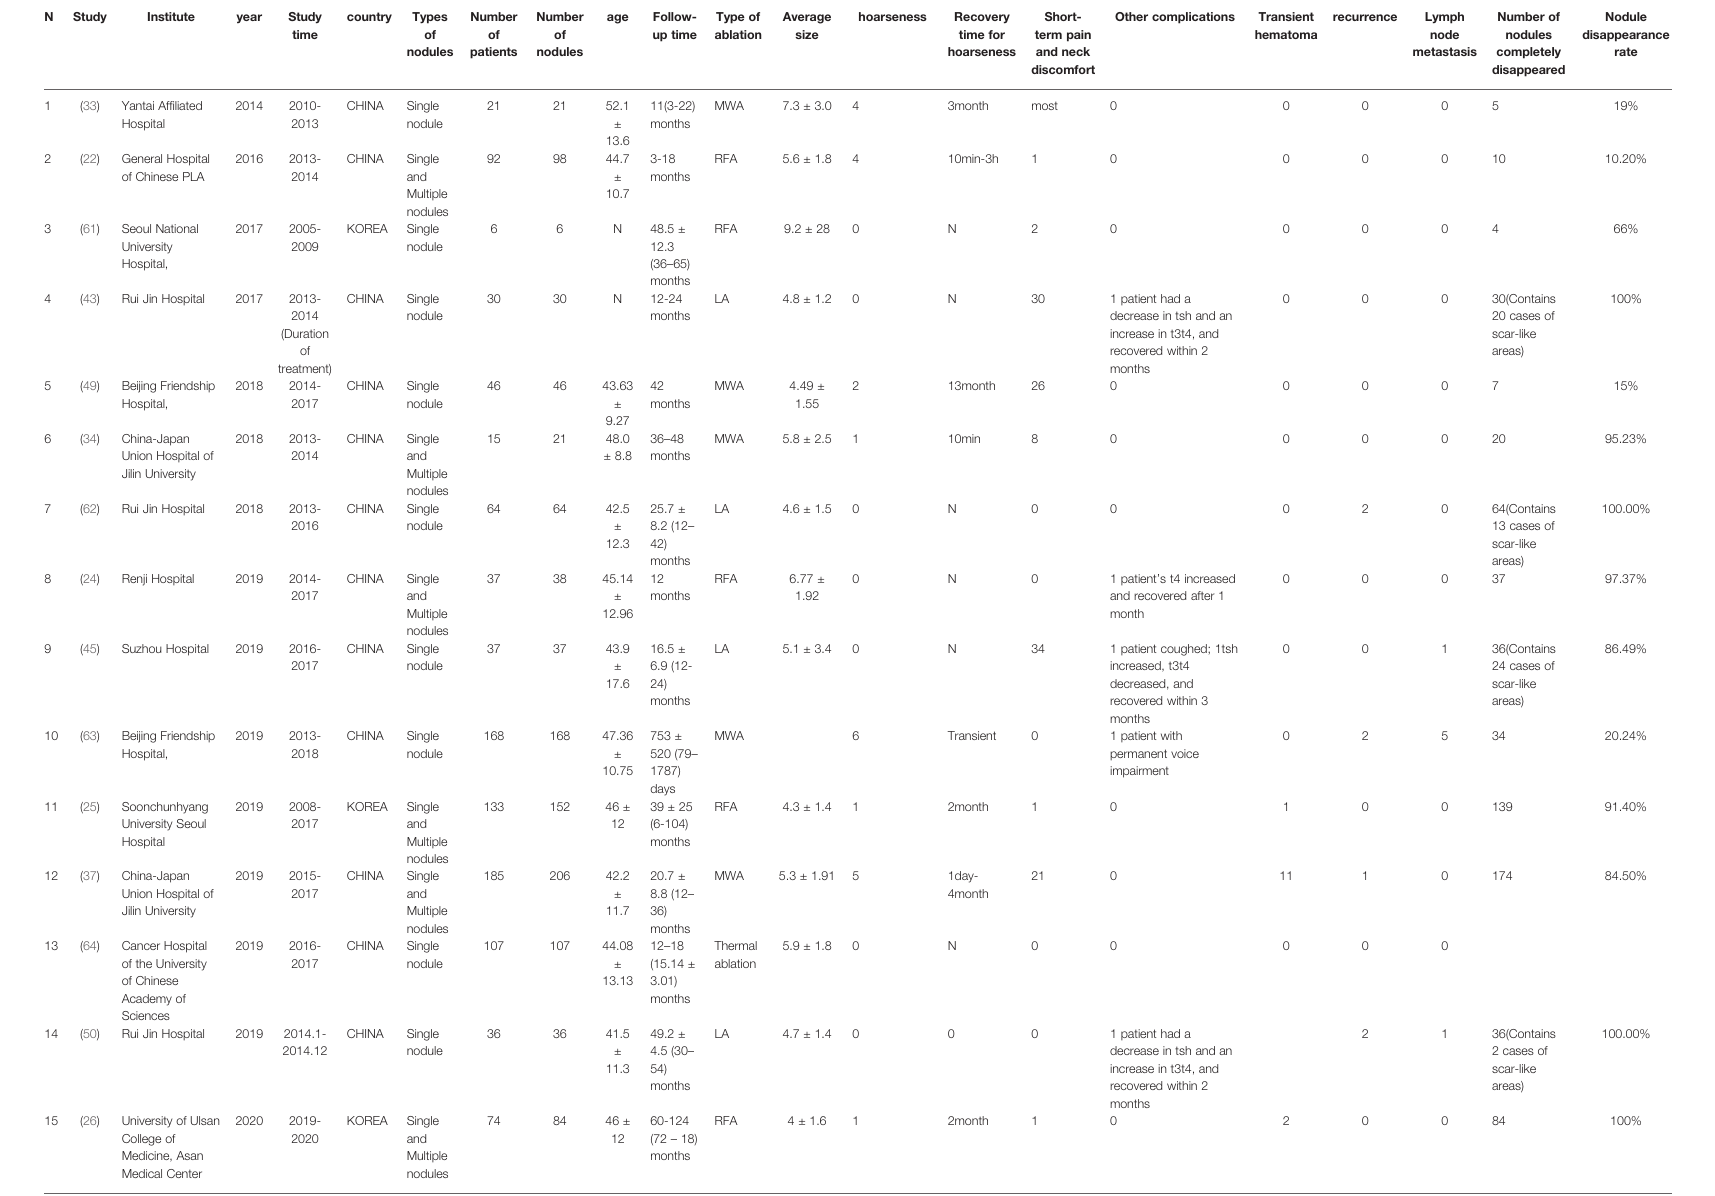
TABLE 1 | Basic information on PTC ablation